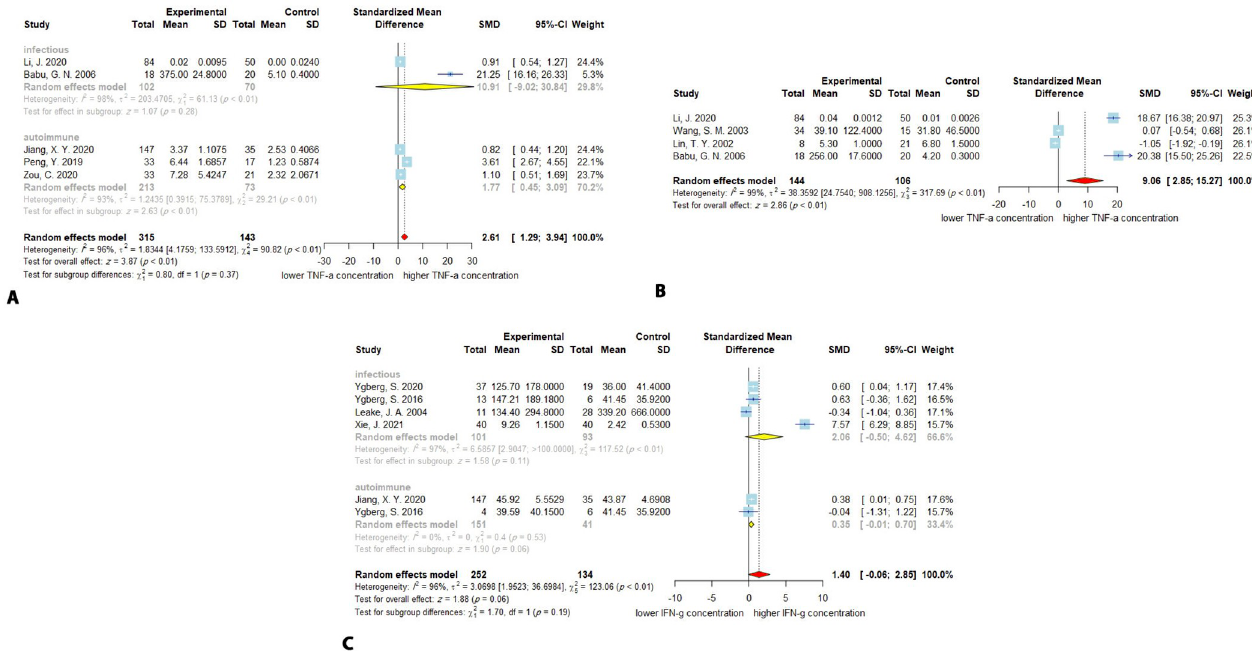
Fig 6. Forest plots for results of the meta-analysis for TNF- α CSF concentrations (A) , TNF- α serum/plasma concentrations (B) , and IFN- γ CSF concentrations (C) . SD, standard deviation; SMD, standardized mean difference; CI, confidence interval.